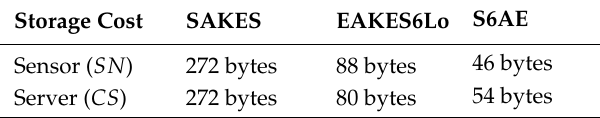
Table 9. Storage cost comparison.